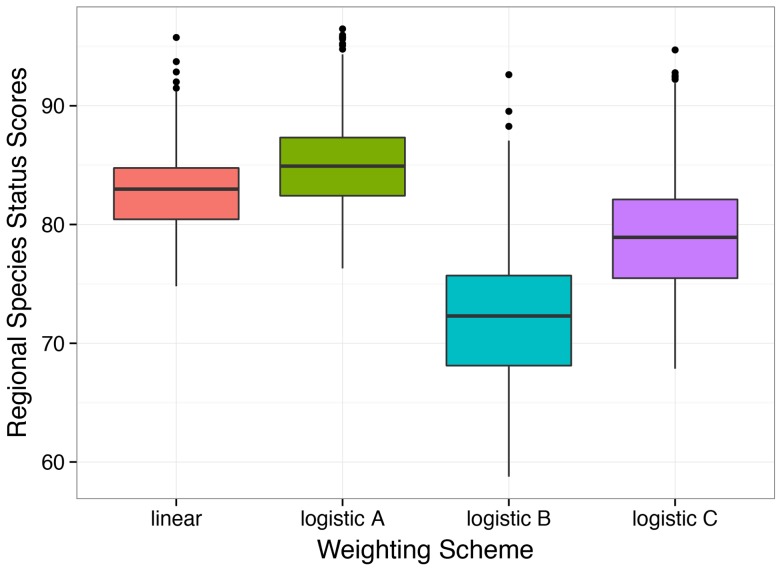
Box plot of EEZ regional species status scores by weighting scheme.Parameters for weighting schemes are in Fig. 1. The median value divides the box, which extends from the first (25%) to the third (75%) quartiles of the distribution. Whiskers extend to the last point within this interquartile range * 1.5 and dots indicate outliers.